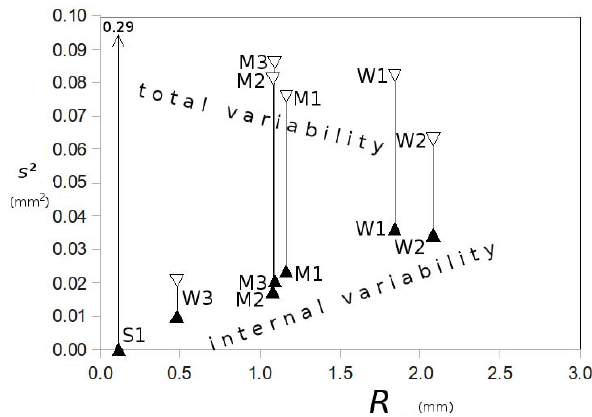
Fig. 8. Total s 2 tot (open triangles), and internal s 2 sample variance of the smoothed precipitation accumulations over the hour preceding the 6, 12, 18, 24, 30, 36, 42, and 48h forecast time, as a function of the ensemble average accumulated precipita- tion over the 48h forecast period R .